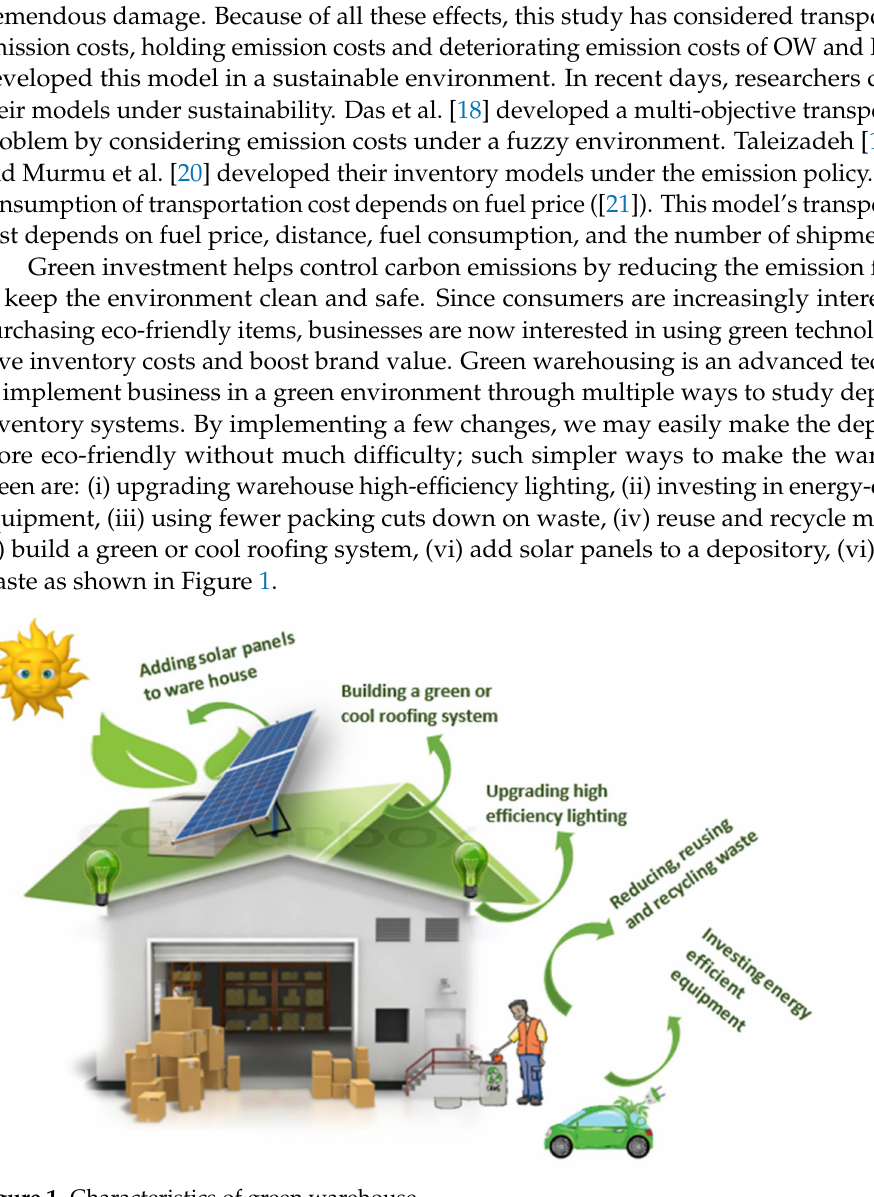
Figure 1. Characteristics of green